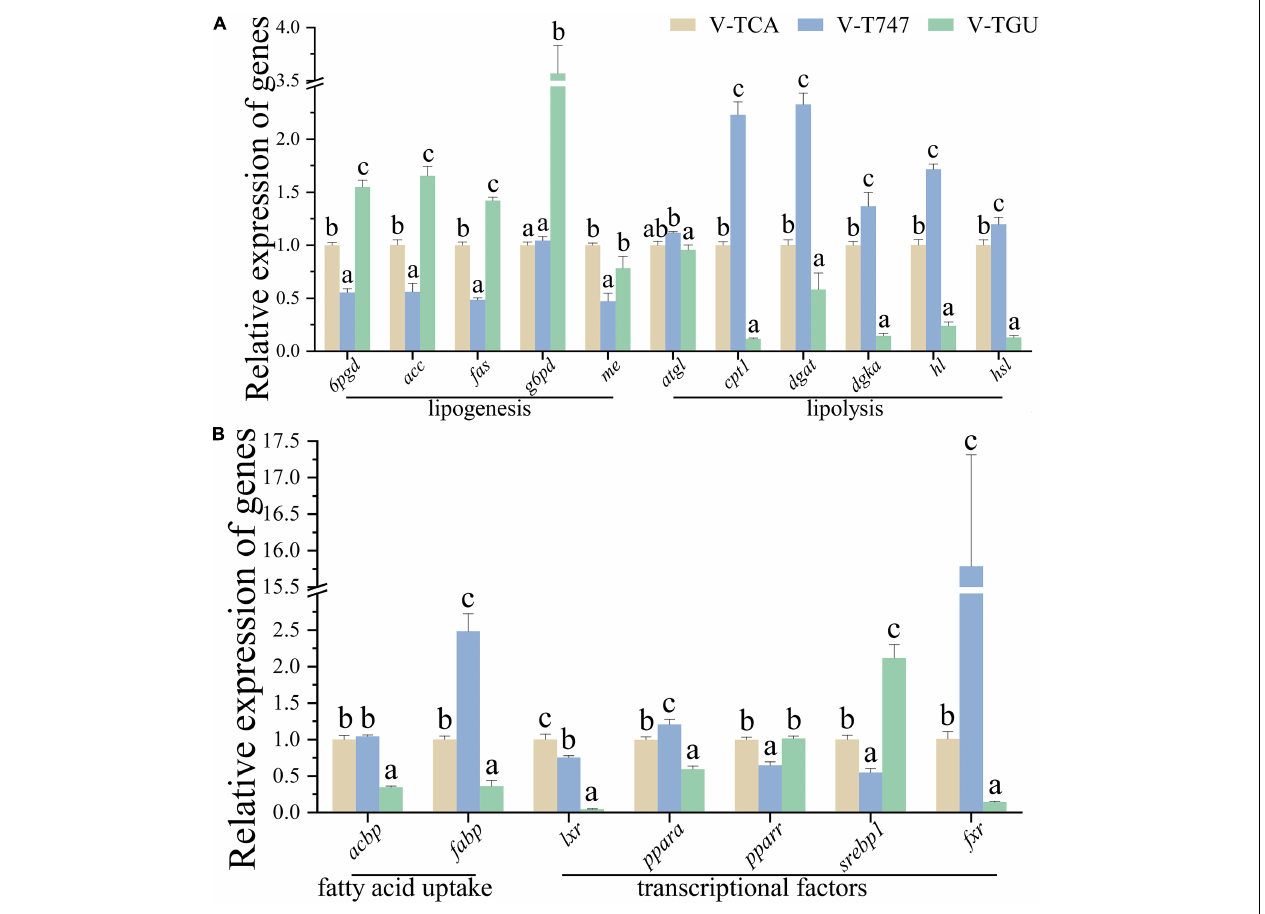
FIGURE 6 | The relative expression of genes associated with lipid metabolism of hepatocytes normalized to 18s and β -actin in FXR agonist or antagonist incubation (A,B) ( n = 9). Values are presented as means with SD , where significant ( p < 0.05) differences between groups are indicated by different letters.